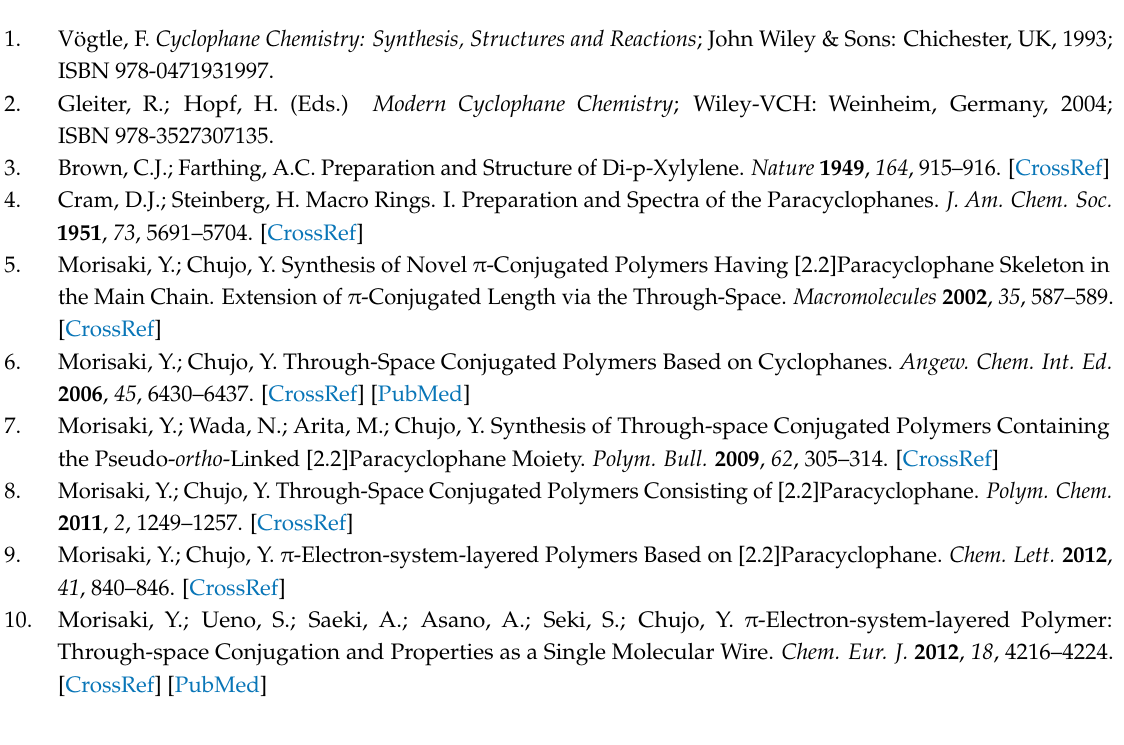
s1, Figure S1: 1 H NMR spectrum of m - P1 , Figure S2: 13 C NMR spectrum of m - P1 , Figure S3: 1 H NMR spectrum of m - D1 , Figure S4: 13 C NMR spectrum of m - D1 , Figure S5: GPC curves of m - P1 and m - D1 , Figure S6: PL decay curve of m - D1 , Figure S7: PL decay curve of m - P1 , Figure S8: UV-vis absorption spectrum of m - P1 film, Figure S9: PL spectrum of m - P1 film excited at 381 nm, Figure S10: Excitation spectrum of m - P1 film monitored at 541 nm, Figure S11: TGA curve of m - P1 , and Figure S12: DSC thermograms of m - P1